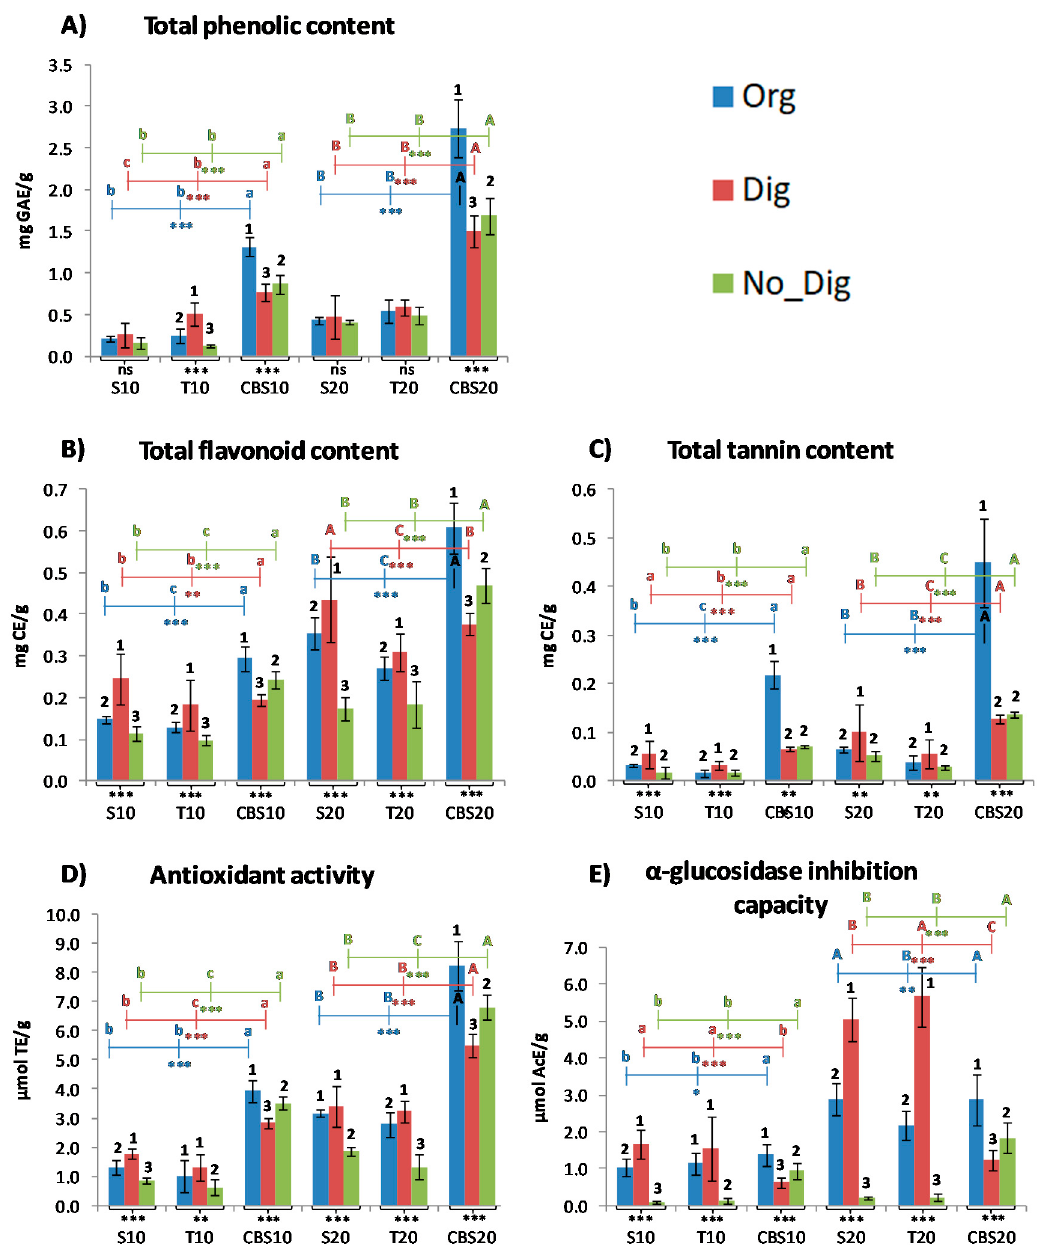
Figure 1. Total phenolic content ( A ), total flavonoid content ( B ), total tannin content ( C ), antioxidant capacity ( D ), and α -glucosidase inhibition capacity ( E ) for the three extraction types (Org, polyphenolic extraction with organic solvents; Dig, in vitro digestion; and No_Dig, no digestion) performed for the cocoa bean shell (CBS) biscuits (S10, T10, S20 and T20) and equivalent quantities of CBS powder alone without the food matrix (CBS10 and CBS20). The results are presented as the mean ± standard deviation (n = 6). Statistical comparisons were made using one-way ANOVA and Duncan’s post-hoc tests at 95% confidence. For each parameter, the different numbers above the bars indicate significant differences at p < 0.05 for the three different types of extraction within the same sample. Different letters indicate significant differences at p < 0.05 for the same extraction within samples with equivalent CBS percentage (lowercase = 10% CBS and uppercase = 20% CBS).